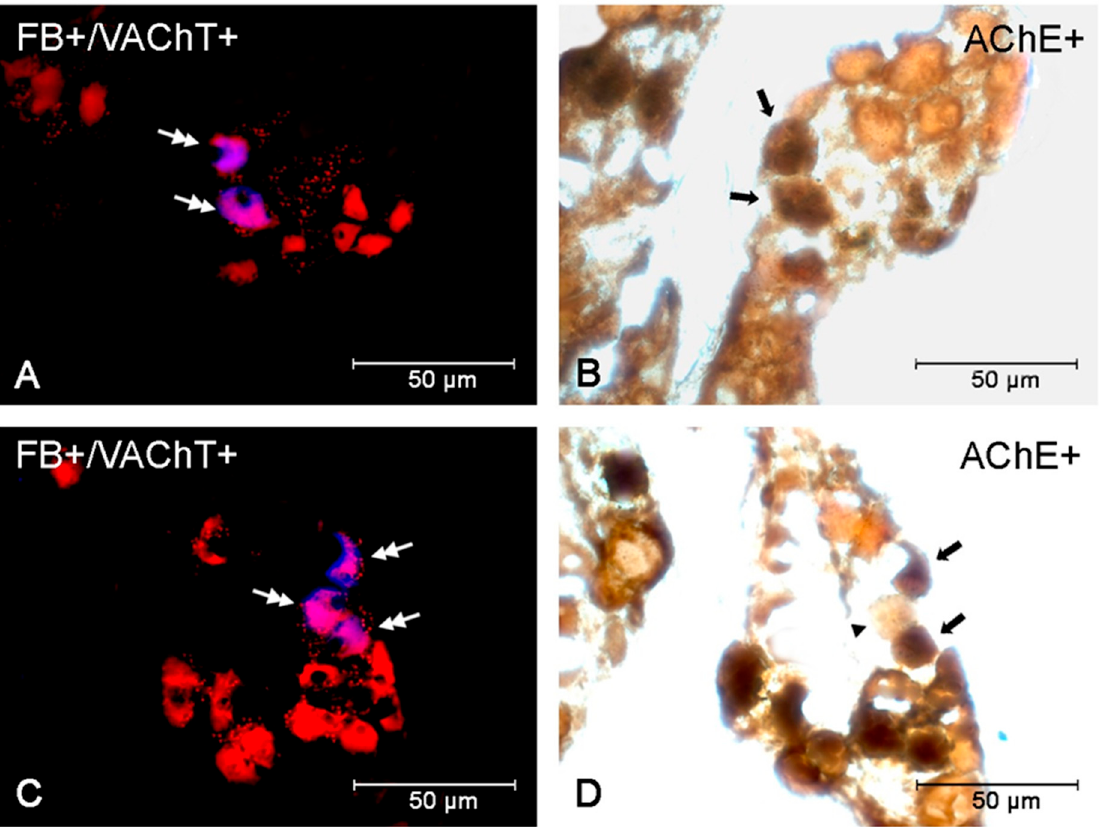
Figure 5. Micrographs demonstrating the presence of uterine, VAChT-positive ( A , C ), and AChE ( B , D ) expressing perikarya in the PCG of gilts from the saline ( A , B ) and E . coli ( C , D ) groups. The double arrow indicates an FB-positive neuron expressing VAChT. The arrow indicates an AChE- positive, whereas the arrowhead indicates an AChE-negative perikaryon. Two uterine neurons ex- pressing VAChT and AChE are visible in the gilt of the saline group ( A , B ). A decreased number of perikarya expressing AChE are present in the PCG of the bacteria-treated group ( C , D